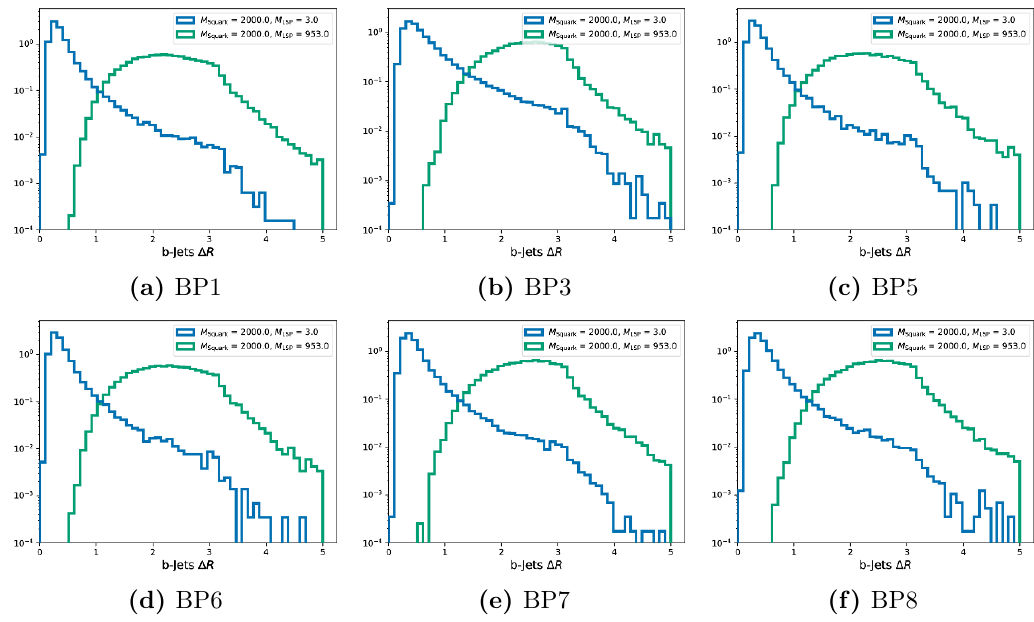
Figure 15. (cid:1) R distributions for low and mid-range M LSP near the observed limit in the BP1- BP8-type mass